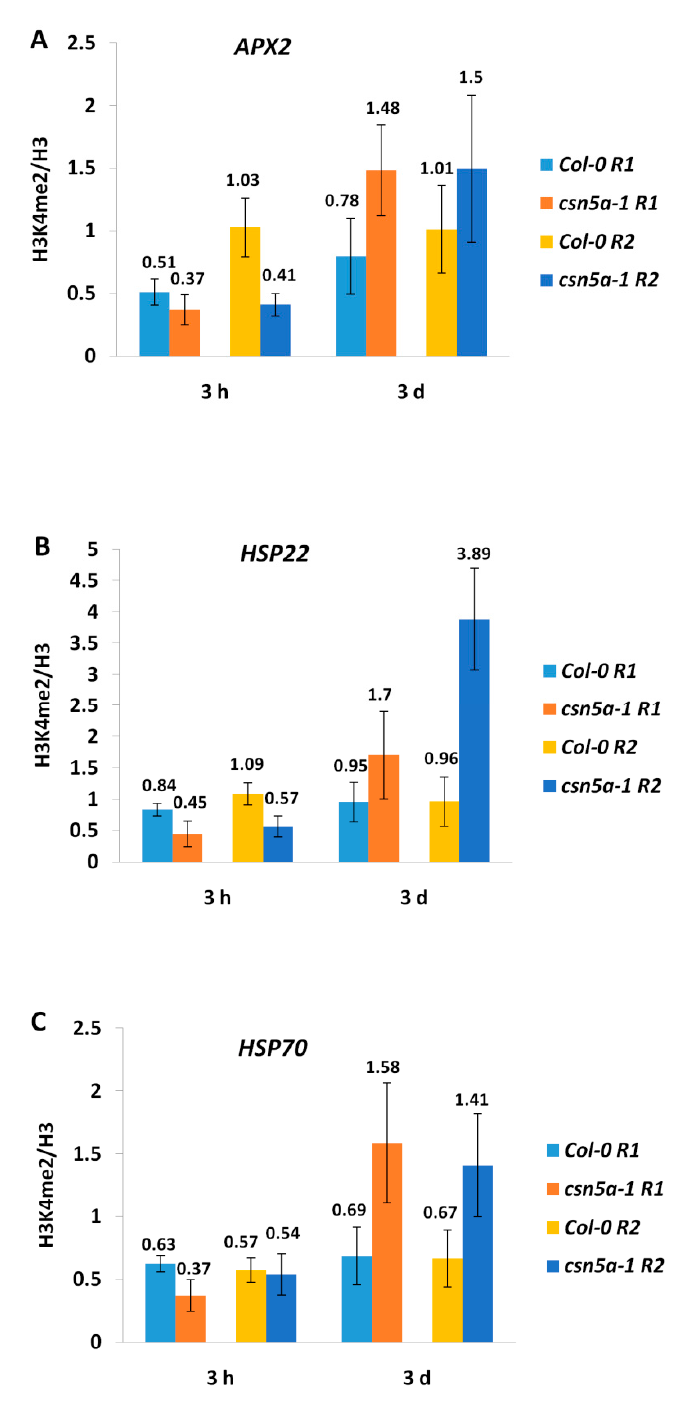
Figure 4. H3K4me2 fold change (heat stress/control) increases 3 d after recurrent heat stress in csn5a-1 . ( A ) H3K4me2 levels of APX2 3 h and 3 d after recurrent heat stress (2 h, 44 °C, 7 d) in Col-0 and csn5a-1 . ( B ) H3K4me2 levels of HSP22 3 h and 3 d after recurrent heat stress (2 h, 44 °C, 7 d) in Col-0 and csn5a-1 . ( C ) H3K4me2 levels of HSP70 3 h and 3 d after recurrent heat stress (2 h, 44 °C, 7 d) in Col-0 and csn5a-1 . ChIP-qPCR was performed with antibodies against H3K4me2 and H3 (for normalization). Amplification values were normalized with H3 and the respective non-heat stress (control) sample at the same point. Error bars represent SEM of biological replicates ( n = 3–4).